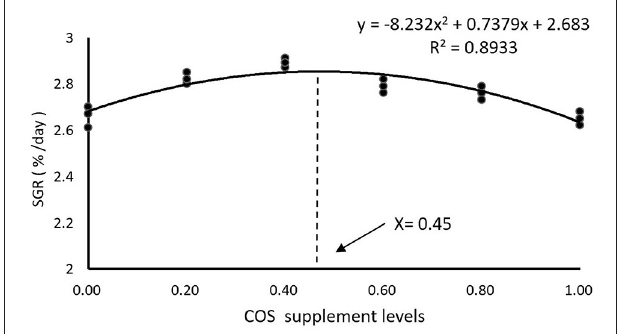
FIGURE 1 | Polynomial curve model analysis of SGR in hybrid grouper fed with experimental diets for 8 weeks.